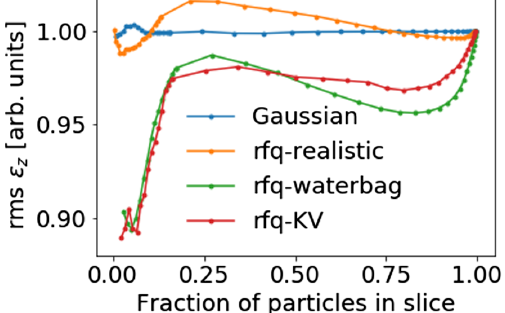
FIG. 3. Dependence of calculated longitudinal emittance on width of the slice in coordinates ð x; x 0 Þ centered at (0,0). Width is expressed as fraction of particles that fall within the slice. Curves are normalized to the 100% emittances reported in Table II. The 6D Gaussian illustrates the effect of particle noise in the narrowest slices.